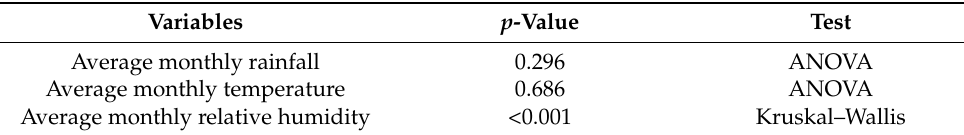
Table 3. Comparison of meteorological variables between the five health districts.